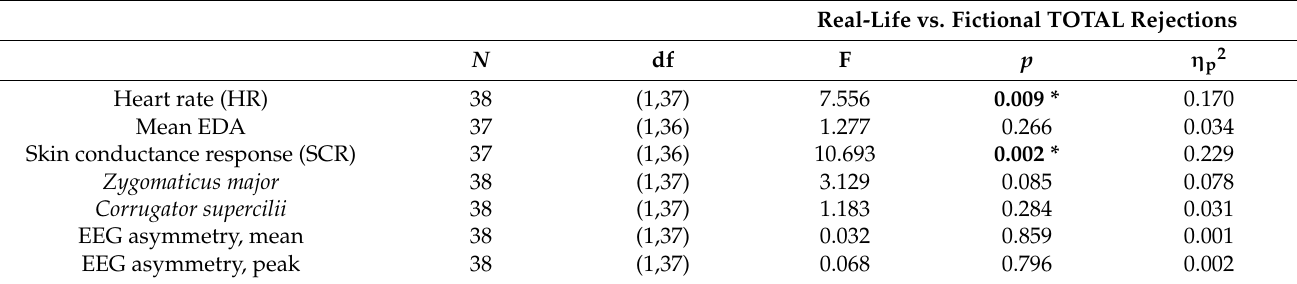
Table 5. Differences in Psychophysiological Reactivity for Combined Social Rejections between Real-Life and Fictional Contexts. Real-Life vs. Fictional TOTAL